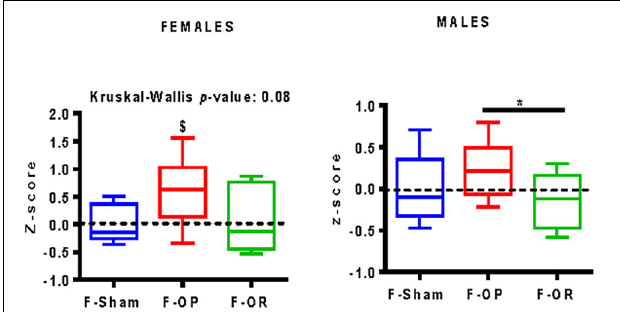
FIGURE 11 | Integrative calculated behavioral z -score of females (left, n = 7–9) and males (right, n = 9–11), data are median and minimum–maximum values; * p < 0.05 indicates difference between groups, Kruskal–Wallis and post hoc Dunn’s test, $ p < 0.05 indicates difference from the reference score value (zero), Wilcoxon signed rank